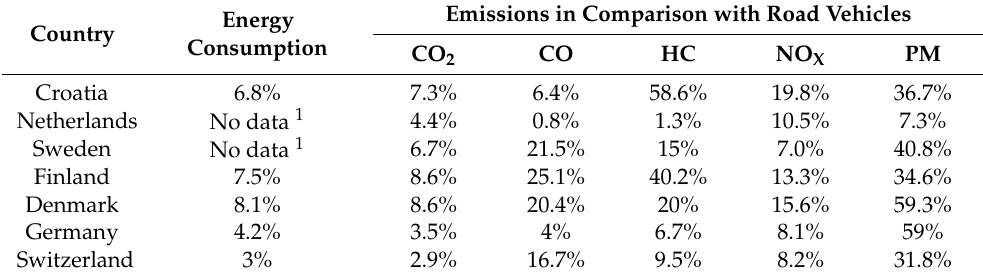
Table 6. Comparison of emissions for Croatia [37,38] and six other European countries which have official data on agricultural machinery emissions: The Netherlands [33], Sweden [34], Finland